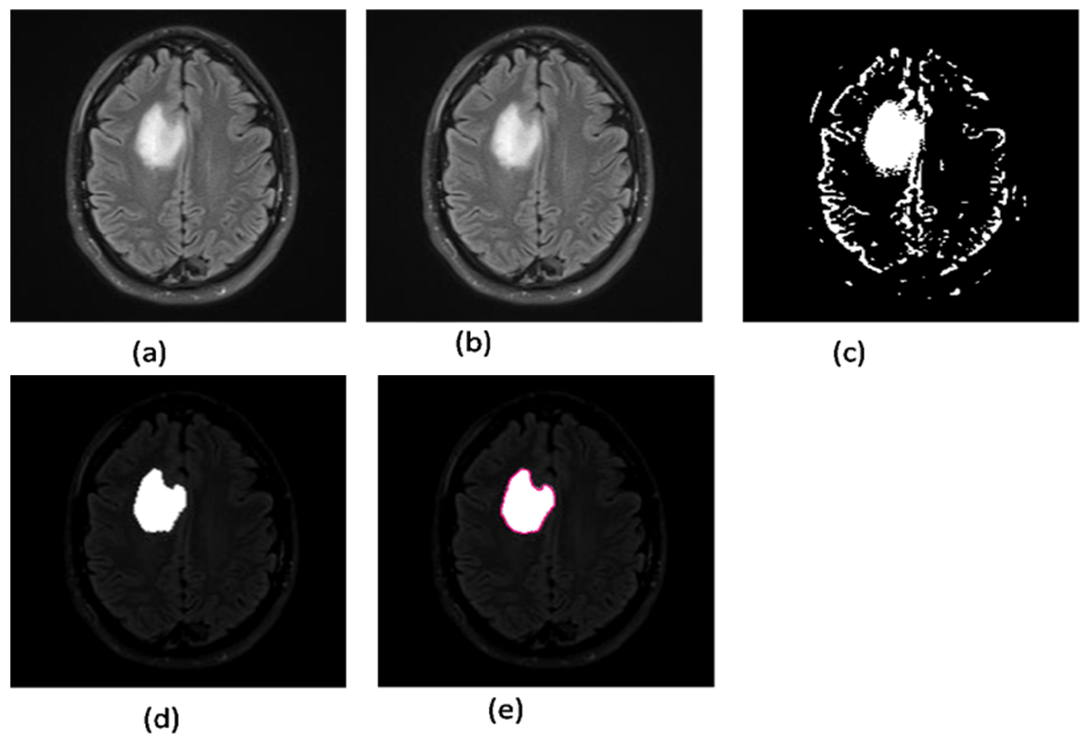
Figure 8. Processing and results of BVH dataset. ( a ) Grayscale image; ( b ) segmentation; ( c ) morpho- logical operations; ( d ) ROI selection and coloring; ( e ) differentiated tissue.